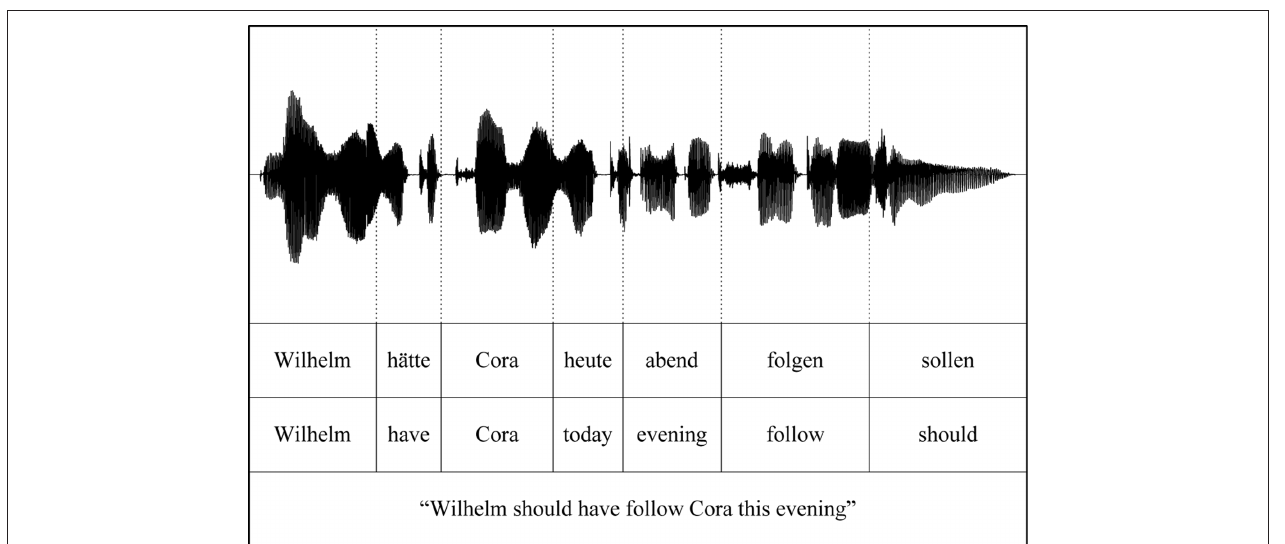
Figure 1 | Word segmentation in auditory and visual language